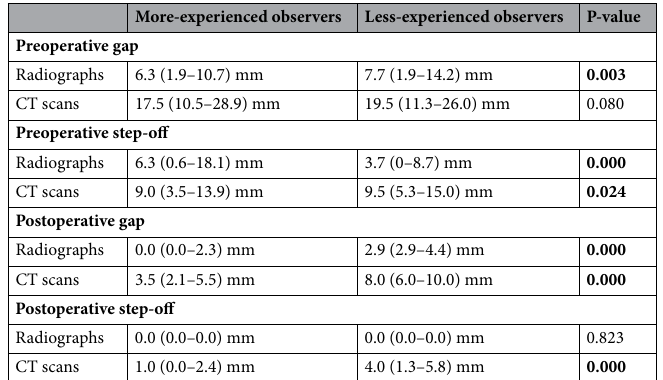
Table 4. Differences in median (interquartile range) gap and step-off measurements between more- experienced and less-experienced observers. P ≤ 0.05 was considered statistically significant.